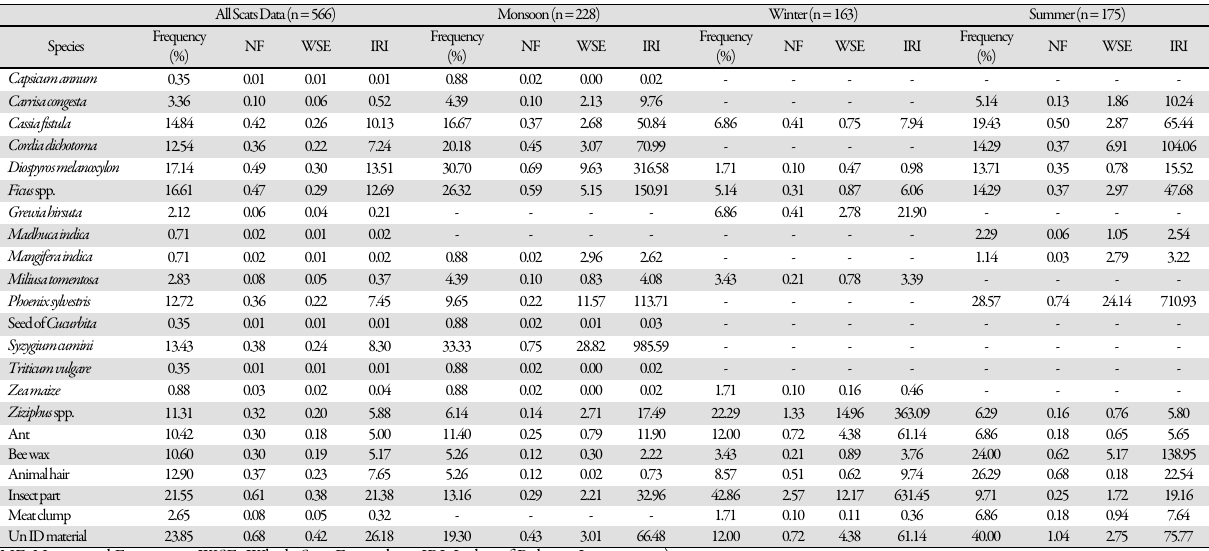
Table 3. Season wise food habits of the Sloth bear (Melursus ursinus) in Banaskantha (Gujarat, India) with their IRI All Scats Data (n =